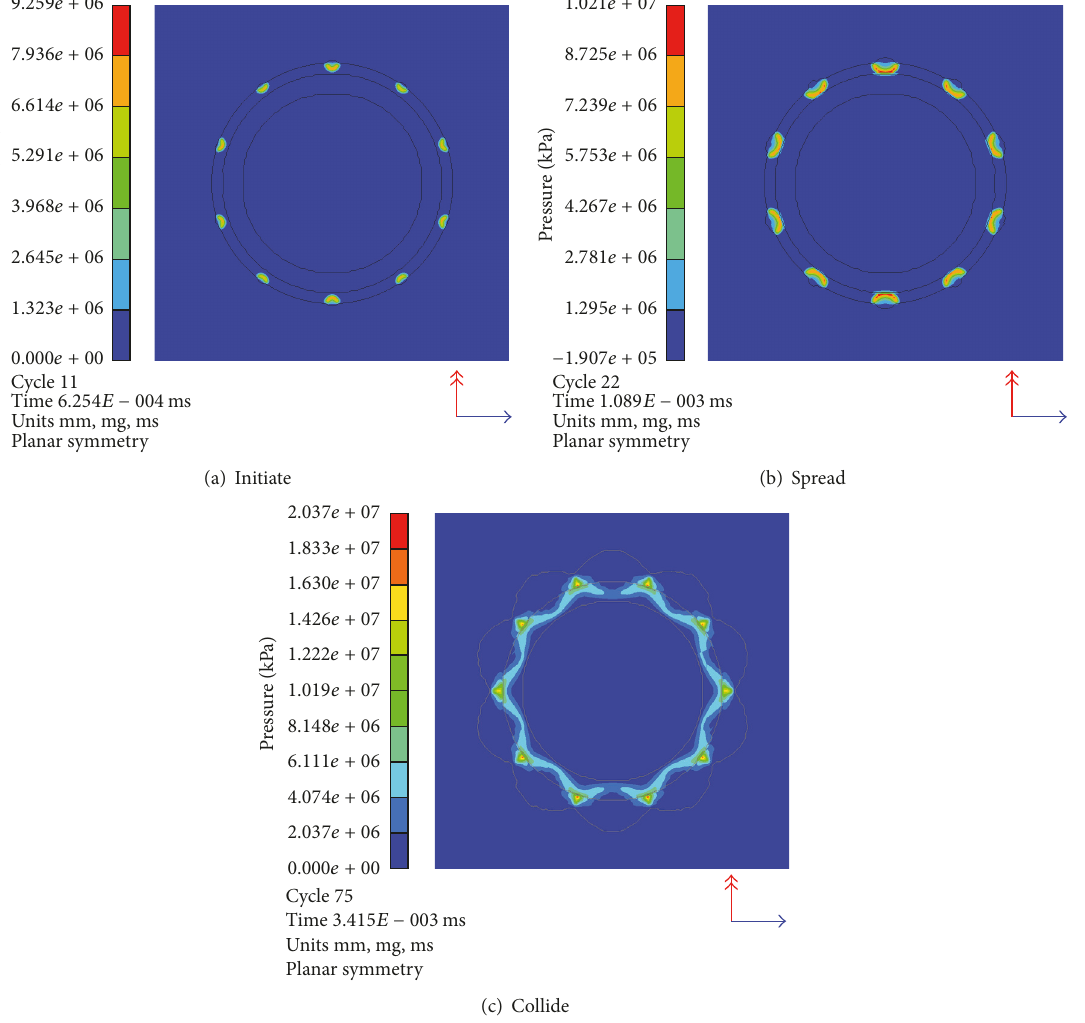
Figure 10: Pressure isograms of tube.